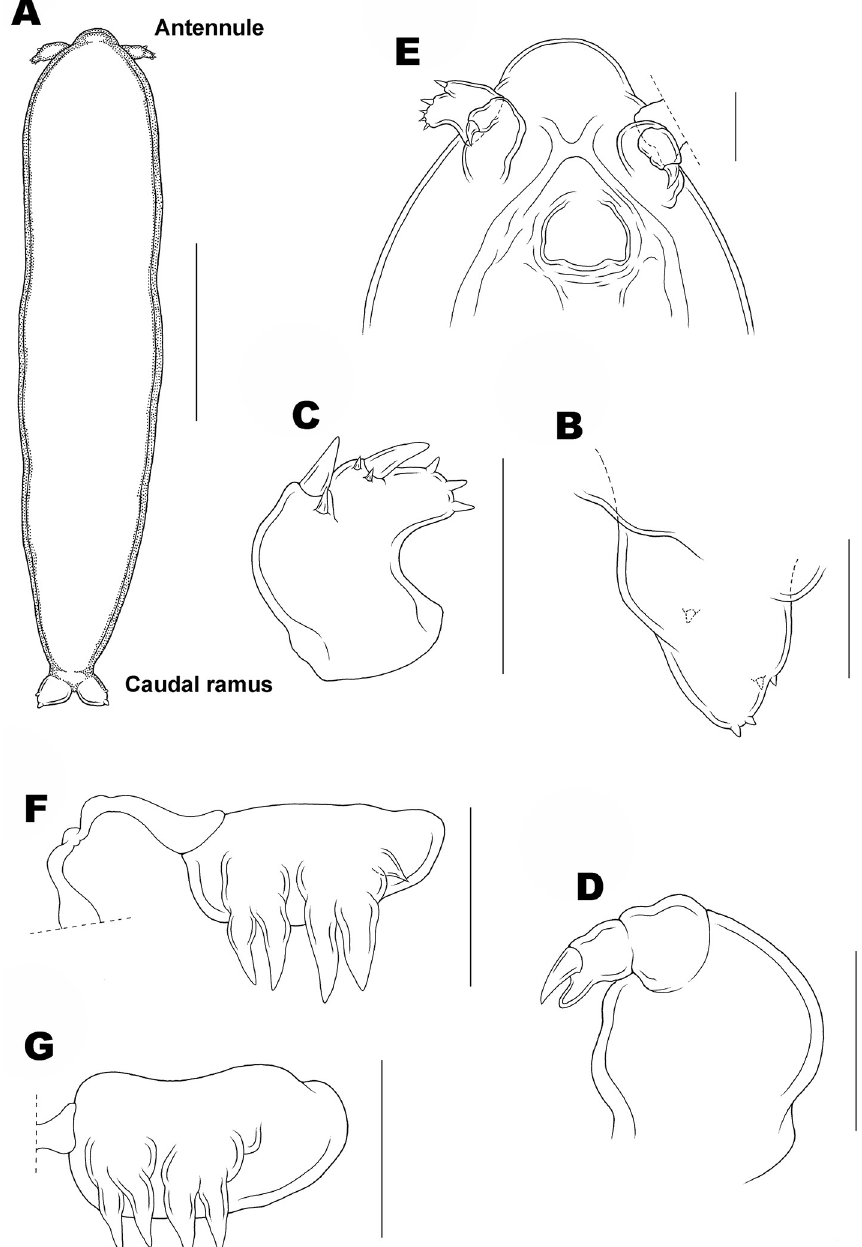
Fig 9. Copepodid stage IV of Ive ptychoderae . (A) Habitus, dorsal; (B) Caudal ramus; (C) Antennule; (D) Antenna; (E) Antennal area and oral region, ventral; (F) Leg 1; (G) Leg 2. Scale bars: A = 0.1 mm; B–G = 0.025 mm. morphological changes. The differences between CI and CII only occurred in the length/width ratio of prosome and armature of antennule and antenna. However, there were dramatic dif- ferences in morphology and behavior since CII stage. The duration of CII to CIII (7 d) and CIII to CIV (9 d) were comparatively longer than that of CI to CII (2 d). Consequently, it took about 2 weeks in total from CII to CIV. It should be mentioned that the duration of CIV lasted